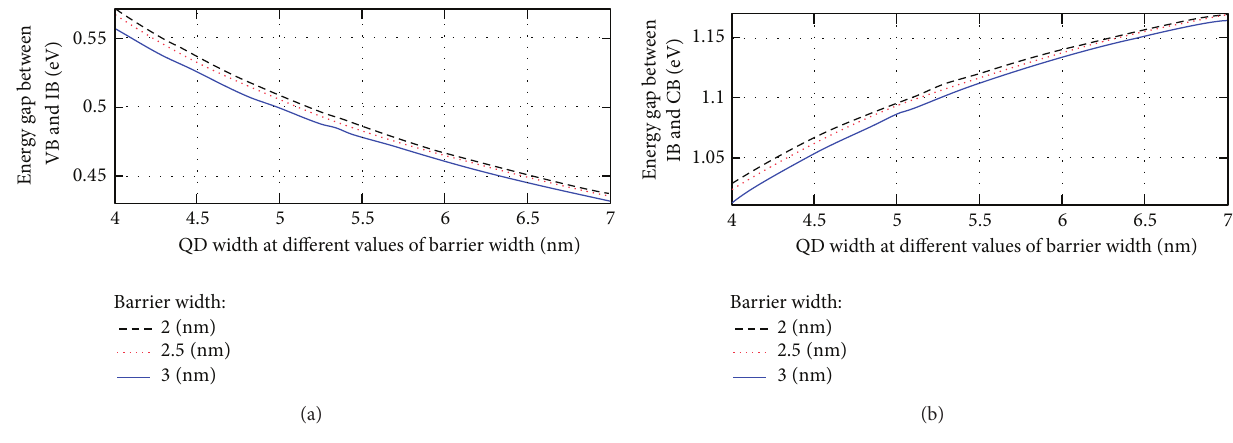
Figure 7: (a) Change energy gap between VB and IB according to change in QD width for the first allowable range at different values of barrier width. (b) Change energy gap between IB and CB with the same conditions in